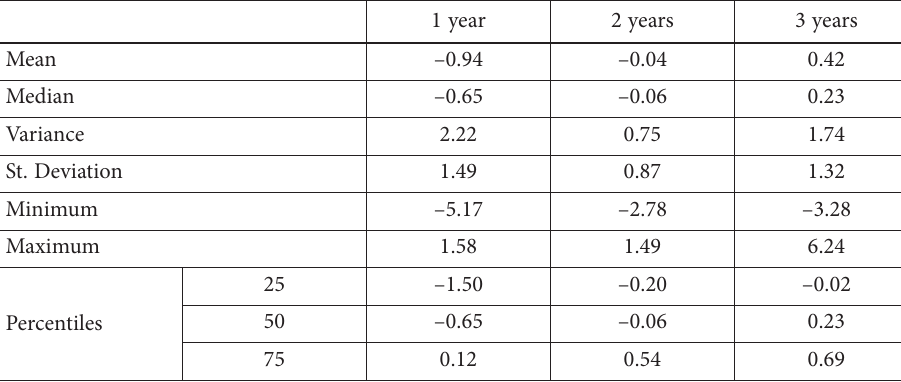
Table 7. Results of Index IN 99 (source: authors based on financial